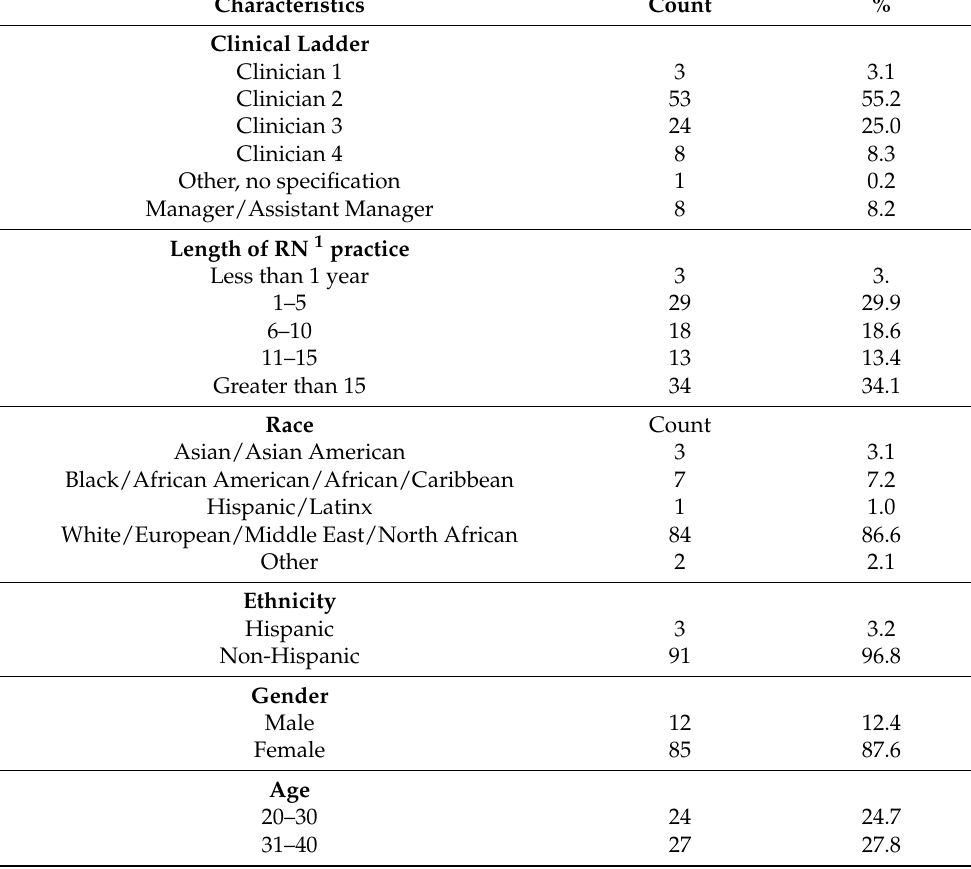
Table 4. Participant Demographics ( n =